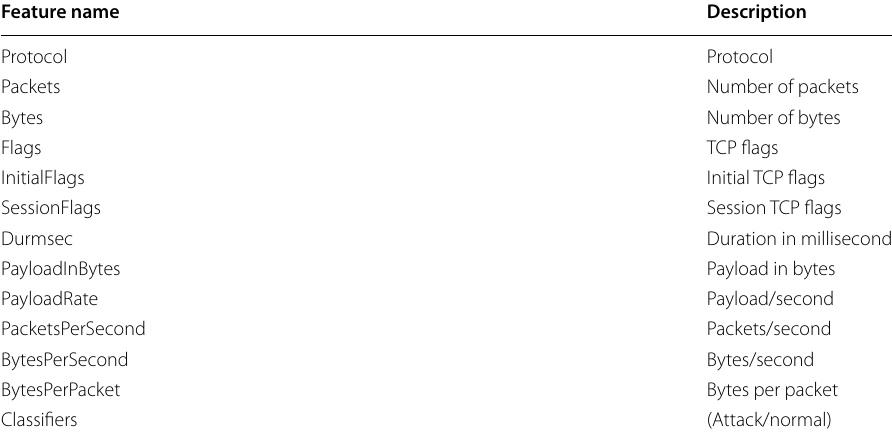
Table 1 Aggregated slow attack feature set